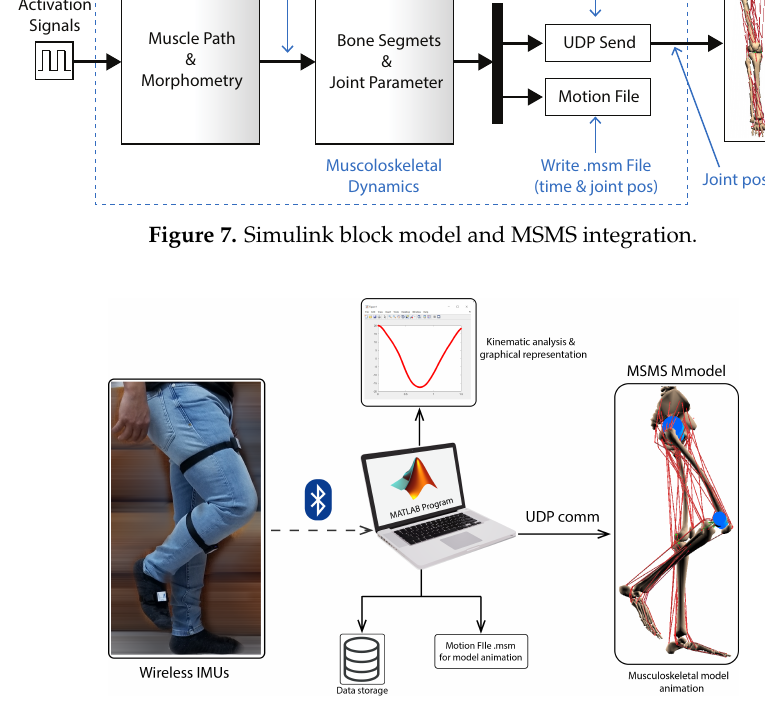
Figure 8. Wireless gait caption system